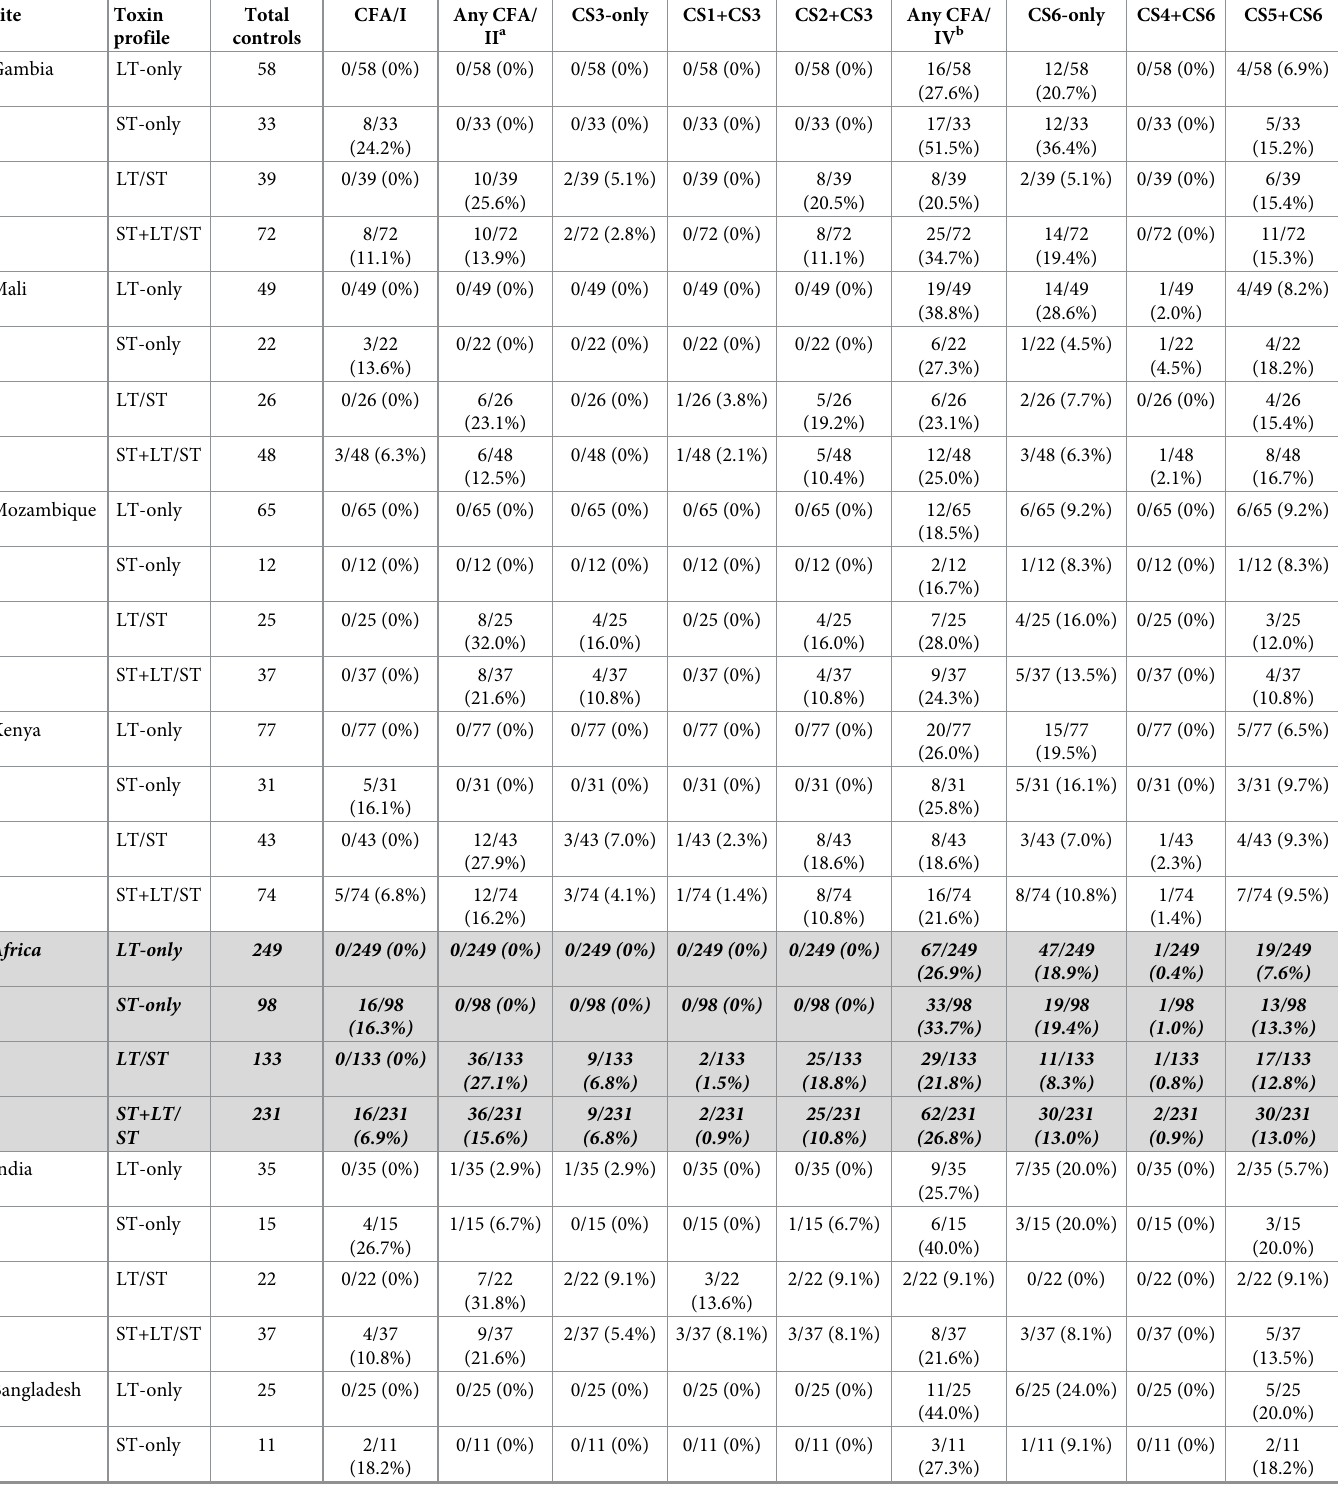
Table 4. The prevalence of major colonization factors that are contained in leading vaccine candidates, by toxin profiles, among ETEC strains from 711 control sub- jects from GEMS sites in Africa and Asia.